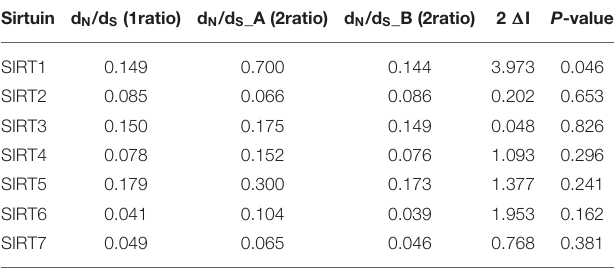
TABLE 1 | Results of the branch model comparison for SIRT protein coding